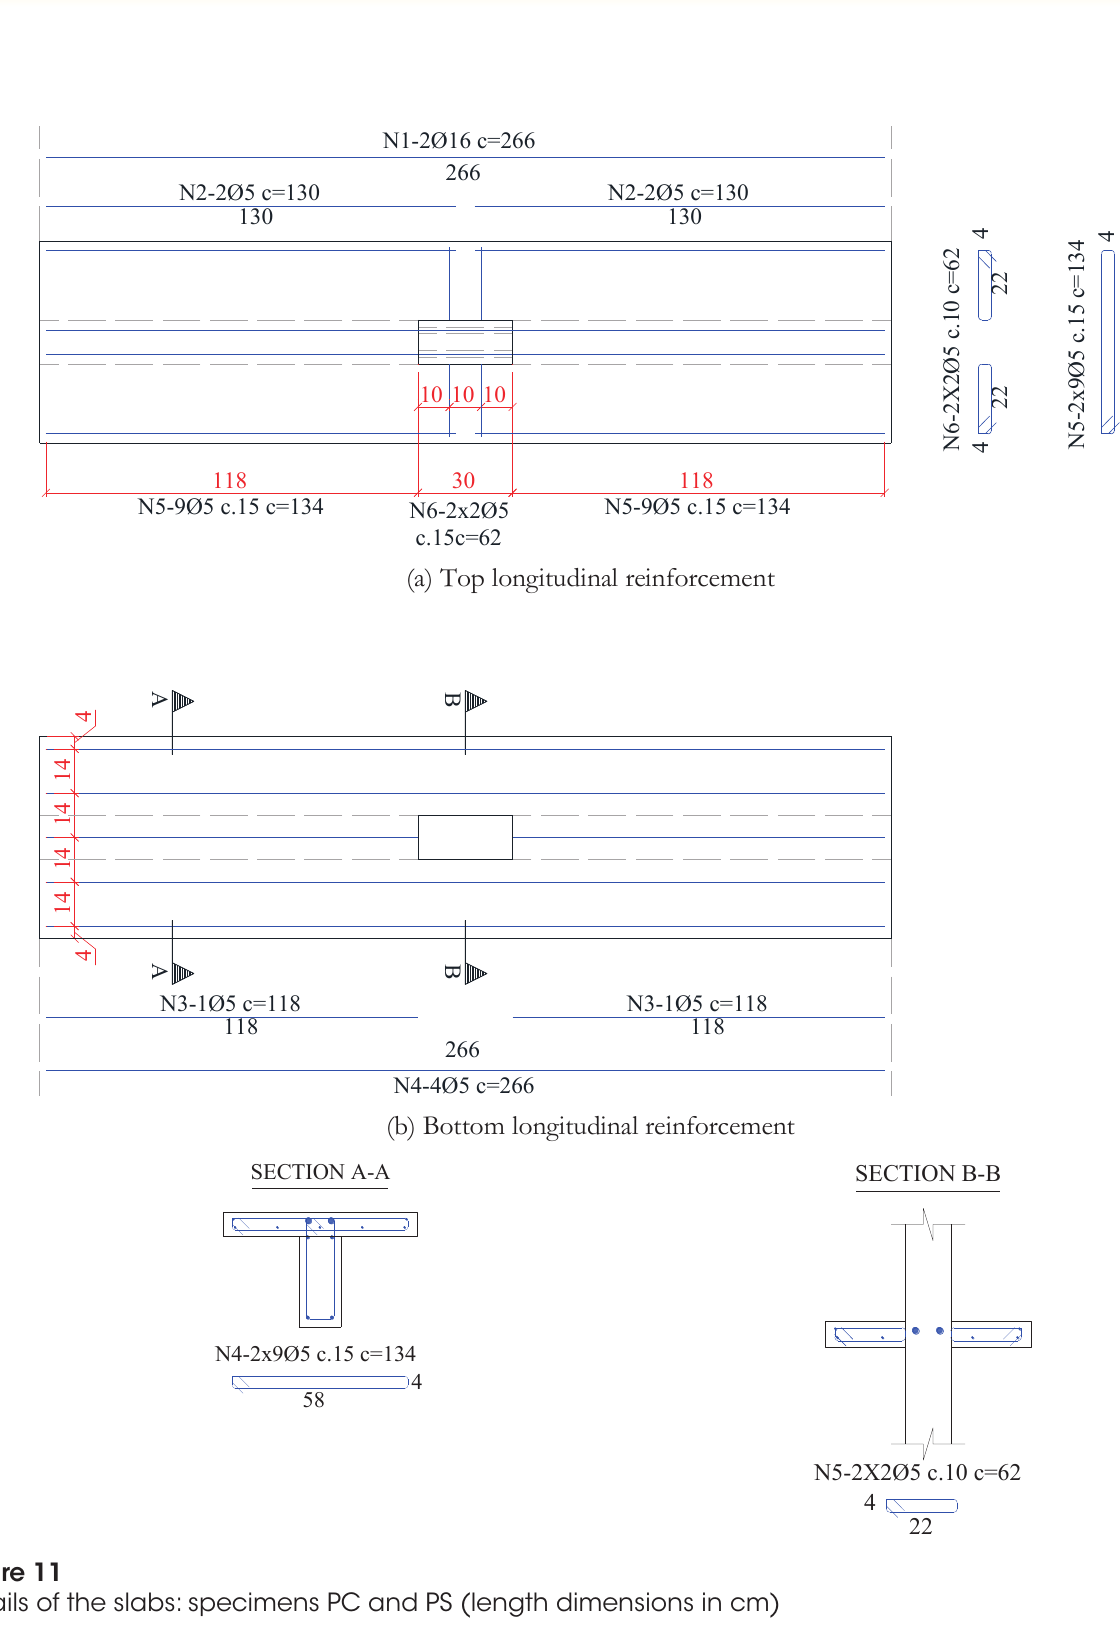
Figure 11 – Details of the slabs: specimens PC and PS (length dimensions in Figure 11 Details of the slabs: specimens PC and PS (length dimensions in cm)